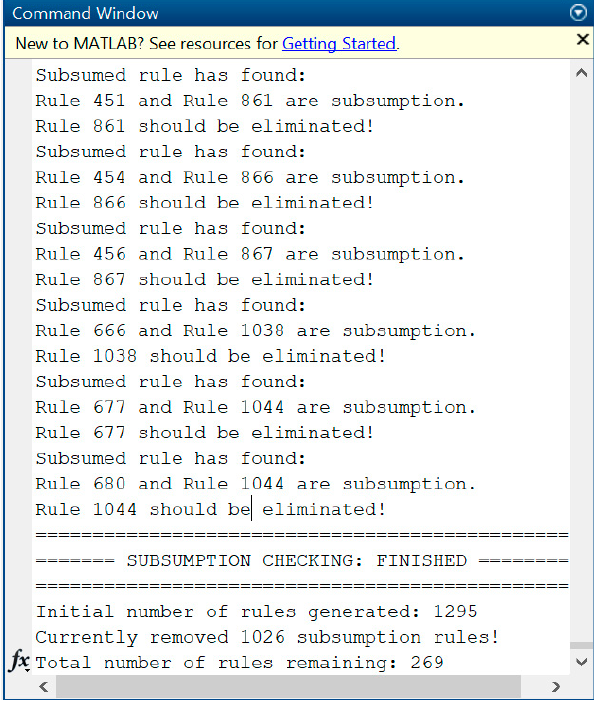
Figure 5. Screenshot of command window MATLAB after subsumption checking.